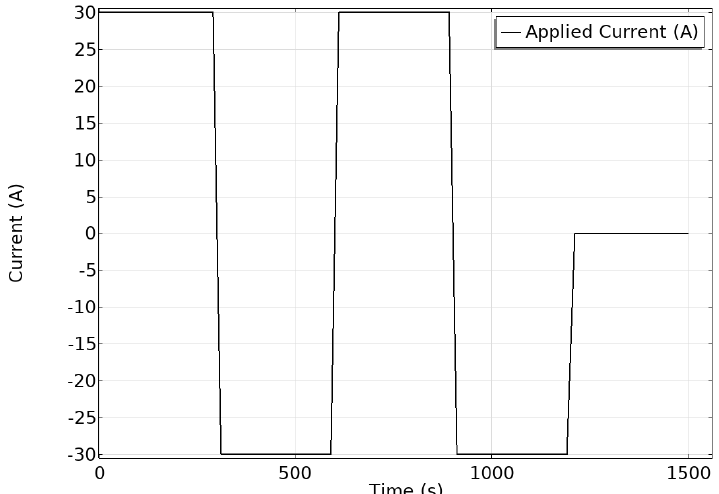
Figure 3. Charge-discharge cycle applied at the battery. E OCV is the battery’s open circuit voltage ( OCV )